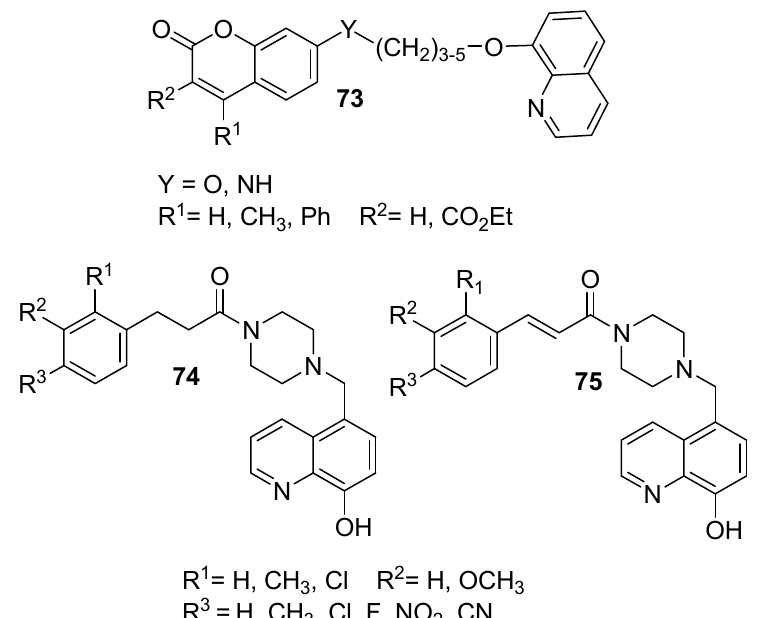
Figure 5. Examples of some representatives of BuChE and AChE inhibitors .